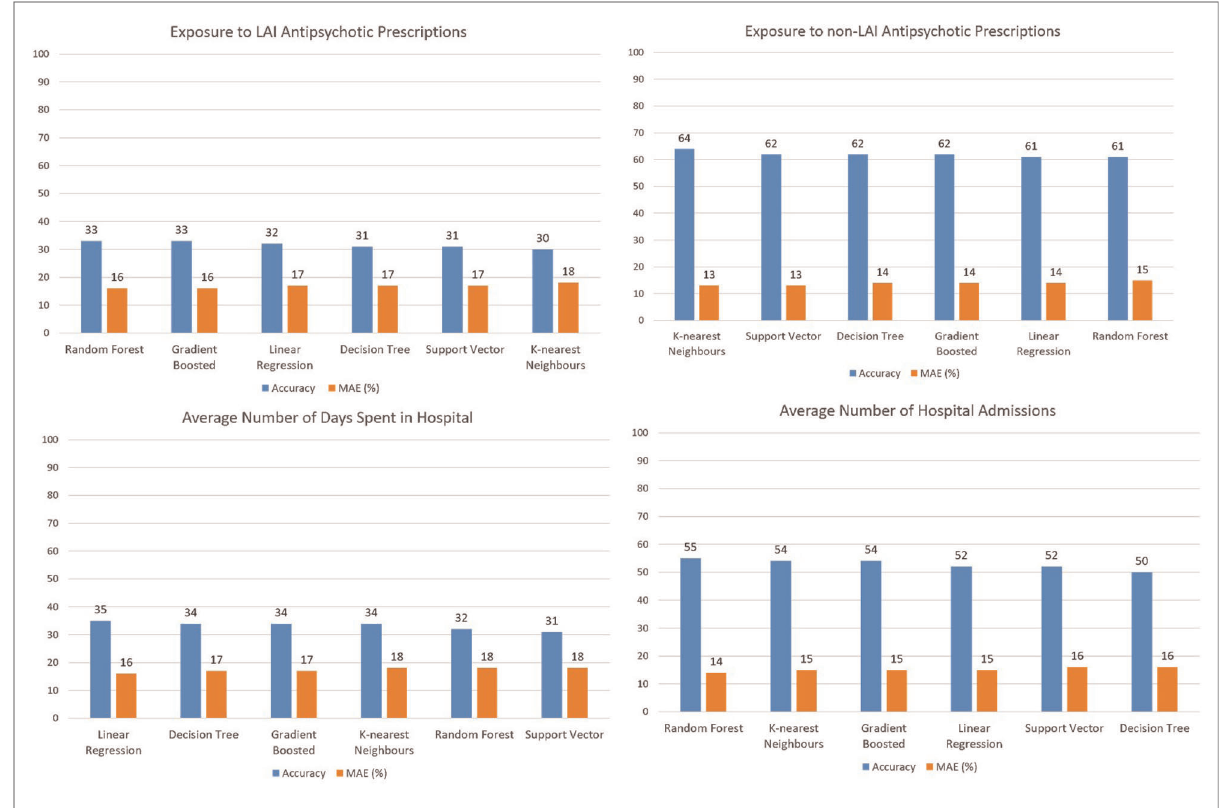
FIGURE 3 Models output